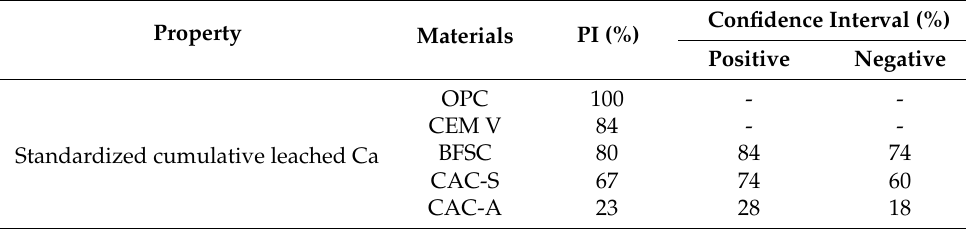
Table 7. Confidence interval for tested materials from four different